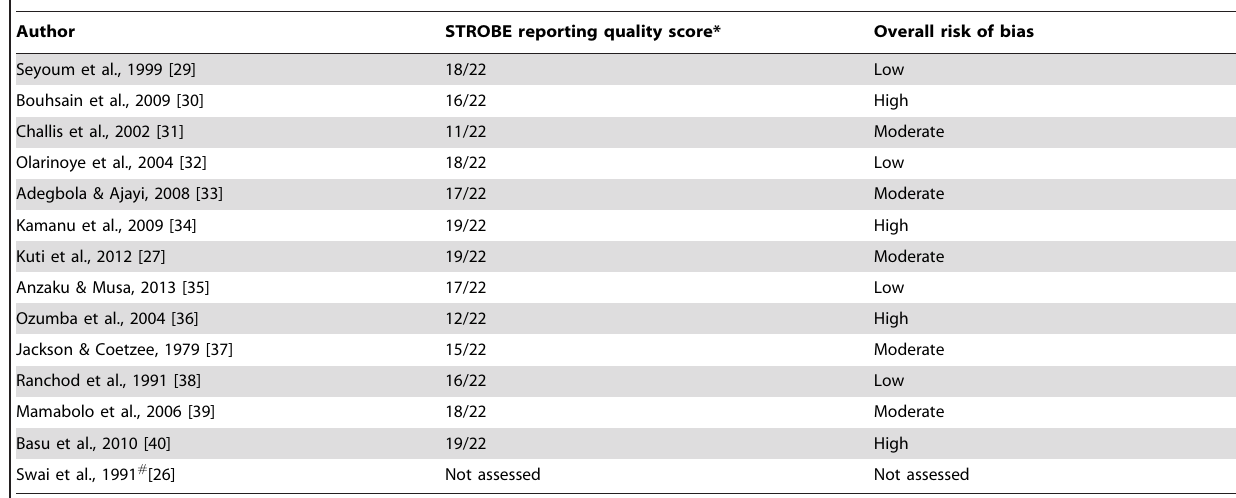
Table 2. Reporting quality and risk of bias